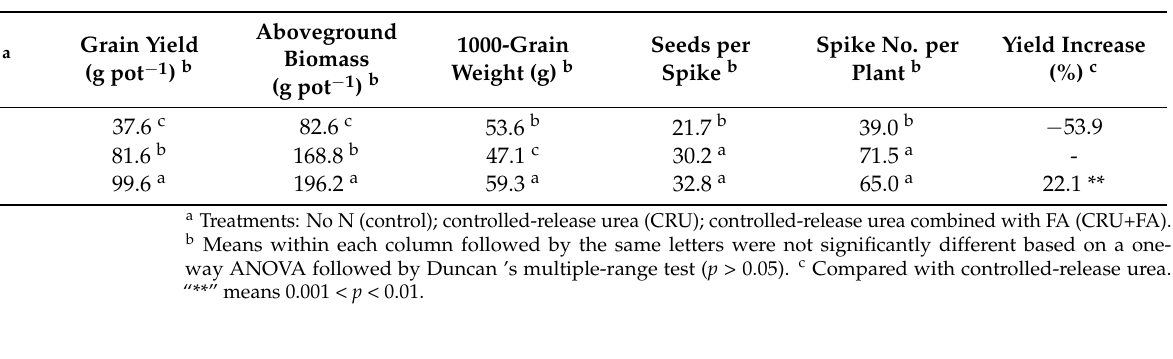
Table 1. Yield and yield components of wheat with different treatments.